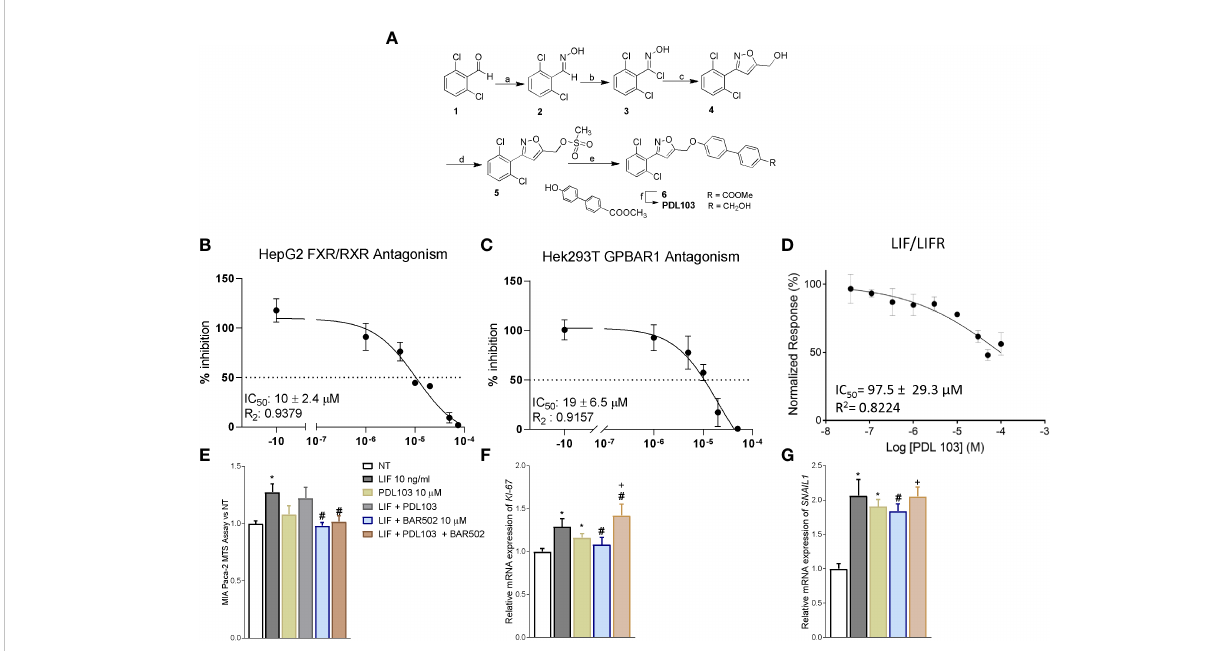
FIGURE 7 The effect of BAR502 is mediated through selectively LIFR inhibition. (A) Scheme 1. Reagents and conditions: a) NH 2 OH·HCl, NaOH, EtOH, D , 98%; b) N-clorosuccinimide, dry DMF, 0°C, 95%; c) propargylic alcohol, NaHCO 3 , CuSO 4 ·5H 2 O, sodium ascorbate, t-BuOH/H 2 O 1:1, quantitative yield; d) methanesulfonyl chloride, TEA, dry THF, 92%; e) methyl 4 ’ -hydroxy-4-biphenylcarboxylate, K 2 CO 3 , dry DMF, 0°C, 66%; f) LiBH 4 , MeOH, dry THF, 0°C, 82%. The synthetic strategy was as following: the commercially available 2,6-dichlorobenzaldehyde (1) was treated with hydroxylamine hydrochloride to form